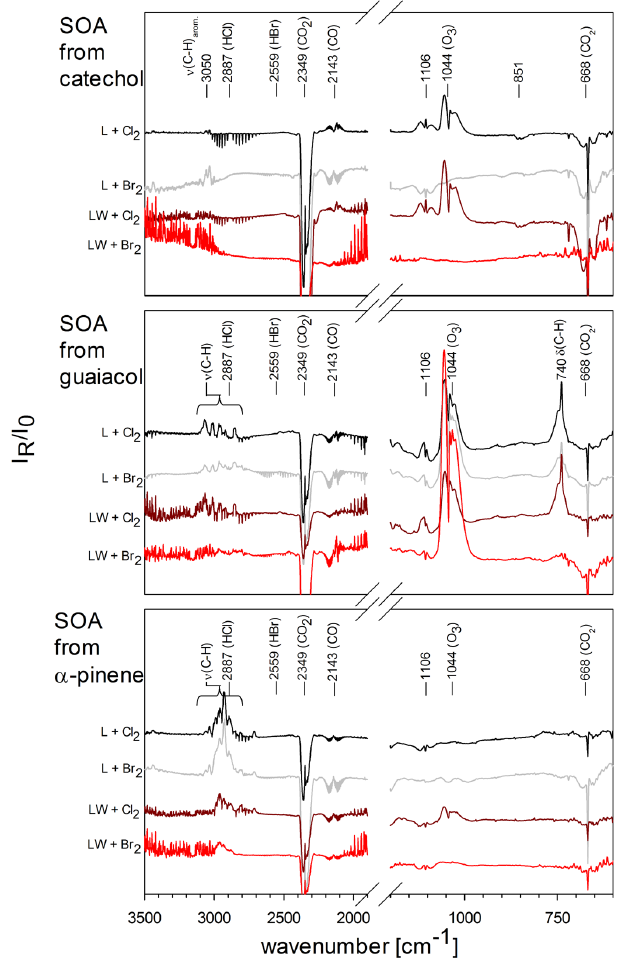
Fig. 4. Long-path absorption FTIR spectra of the heterogeneous re- action of SOA with RHS: L: SOA formed with simulated sunlight at 0% relative humidity; LW: SOA formed with simulated sun- light at 25% relative humidity. Due to the fact, that the represented spectra are transmission spectra, positive absorptions correspond to decreasing species, while negative absorptions indicate increasing